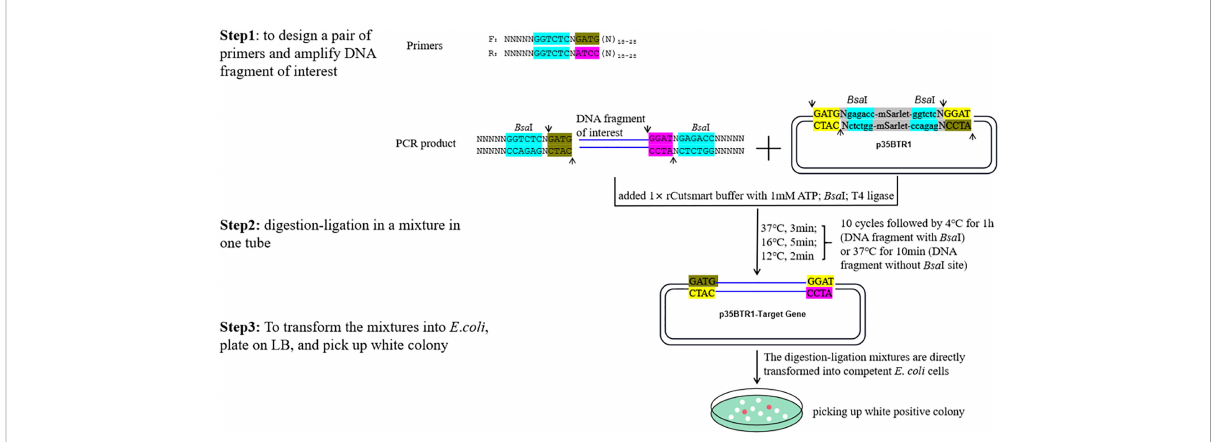
FIGURE 4 An example of the schematic of the construction of a pBTR vector using one-step digestion – ligation. N 18-28 represents any 18 – 28 nt sequences (forward or reverse primers) paired with the FDI. Arrows indicate the digestion site by Bsa I. The Bsa I recognition sites are shown in blue. Two tandem Bsa I recognition sites and neighboring sequences were incorporated into the pBTR vectors. FDI was cloned into p35BTR1, generating a recombinant product lacking the original Bsa I restriction